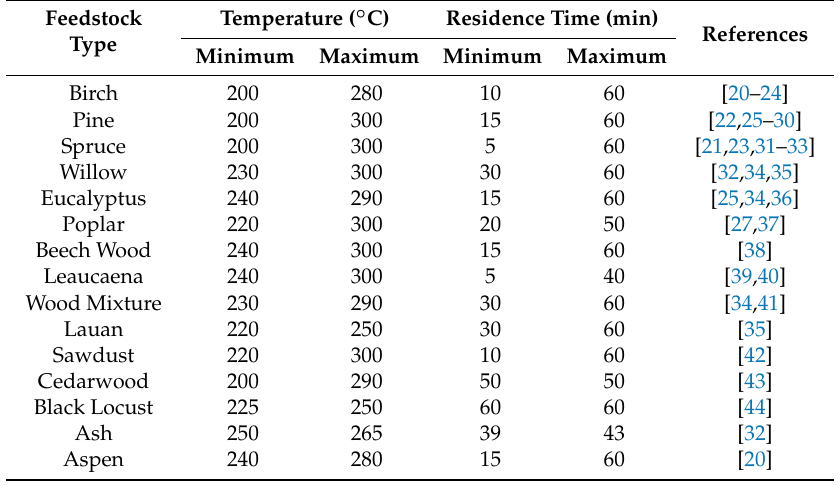
Table 1. Summary of the experimental conditions of torrefaction (categorized by the feedstock